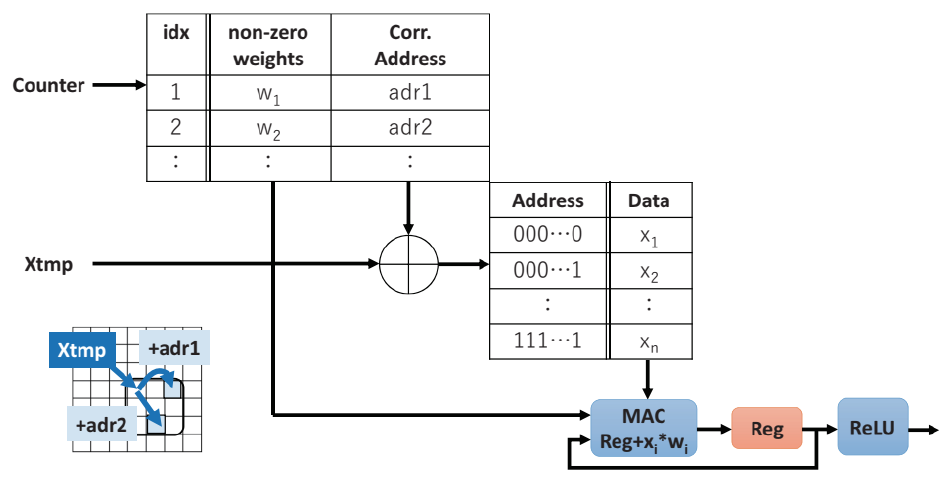
Figure 7. Indirect memory access operation.